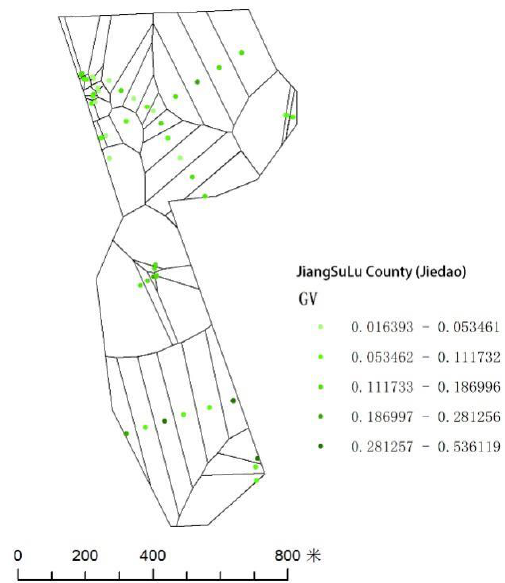
Figure 6. Thiessen polygon of each sampling point in Jiang Su Lu county (jiedao).